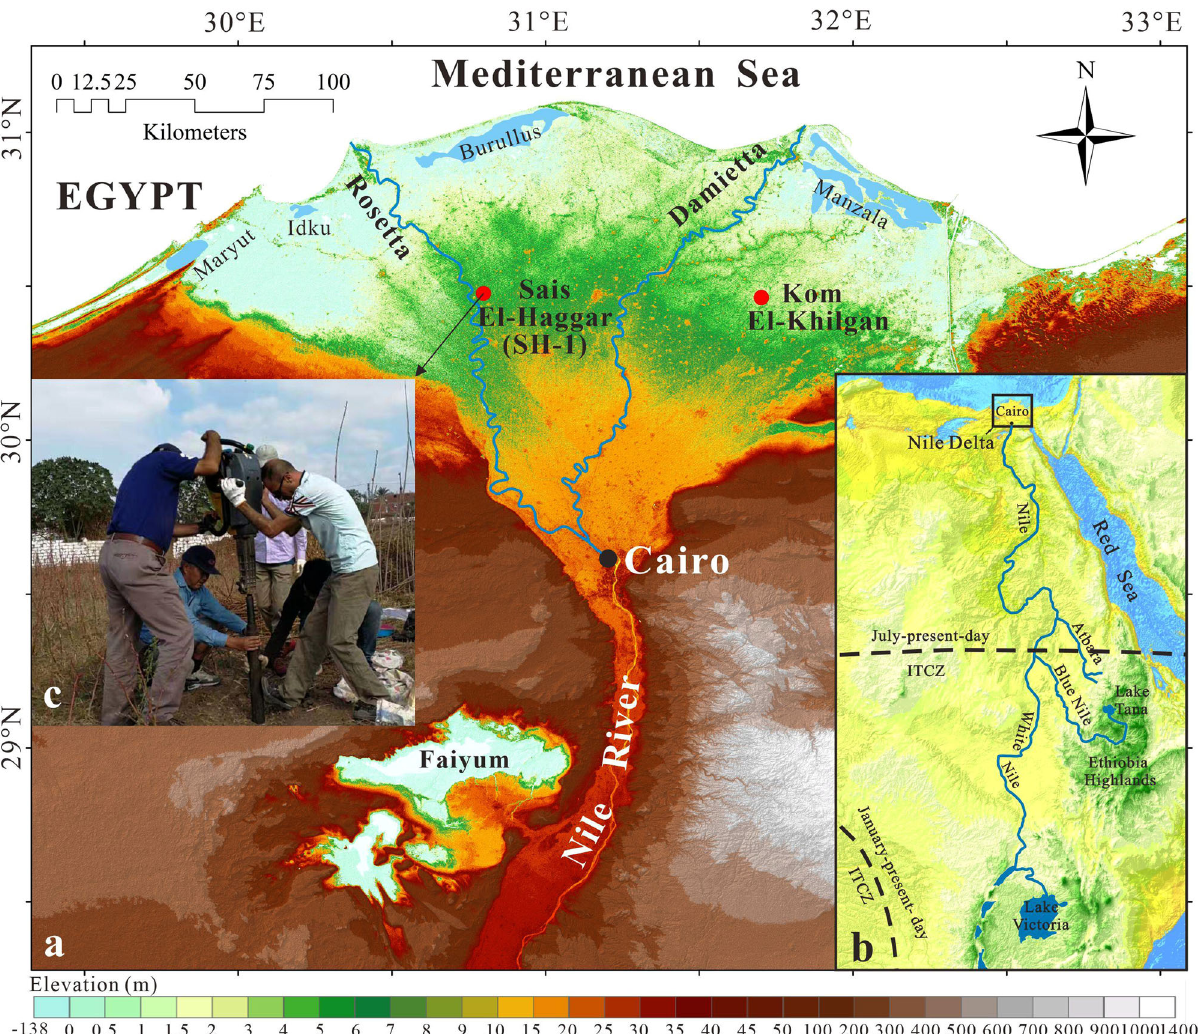
Fig. 1 Map of the Nile Delta and the Nile River Basin. In this map shown are the archaeological sites of Sais El-Haggar (Predynastic) and Kom El-Khilgan (Predynastic) ( a ), the entire Nile River Basin ( b ), and coring at Sais ( c ) (delta images were formed by authors with SRTM open source at: